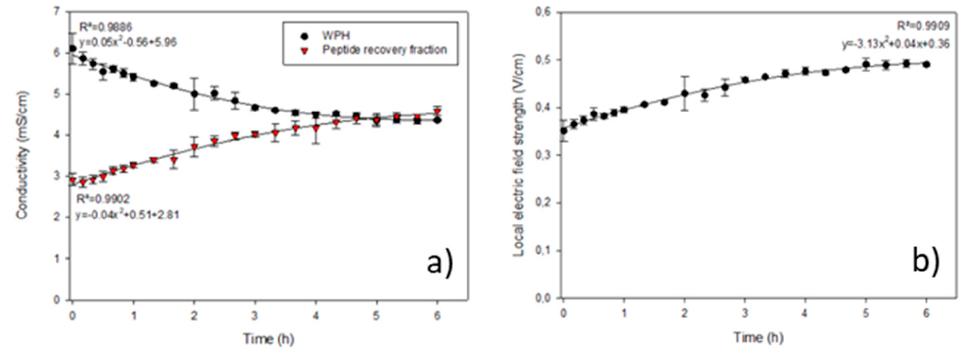
Figure 2. Evolution as a function of time of ( a ) the conductivity of the whey protein hydrolysate (WPH) and peptide recovery fraction and ( b ) the local electric field strength in the WPH.